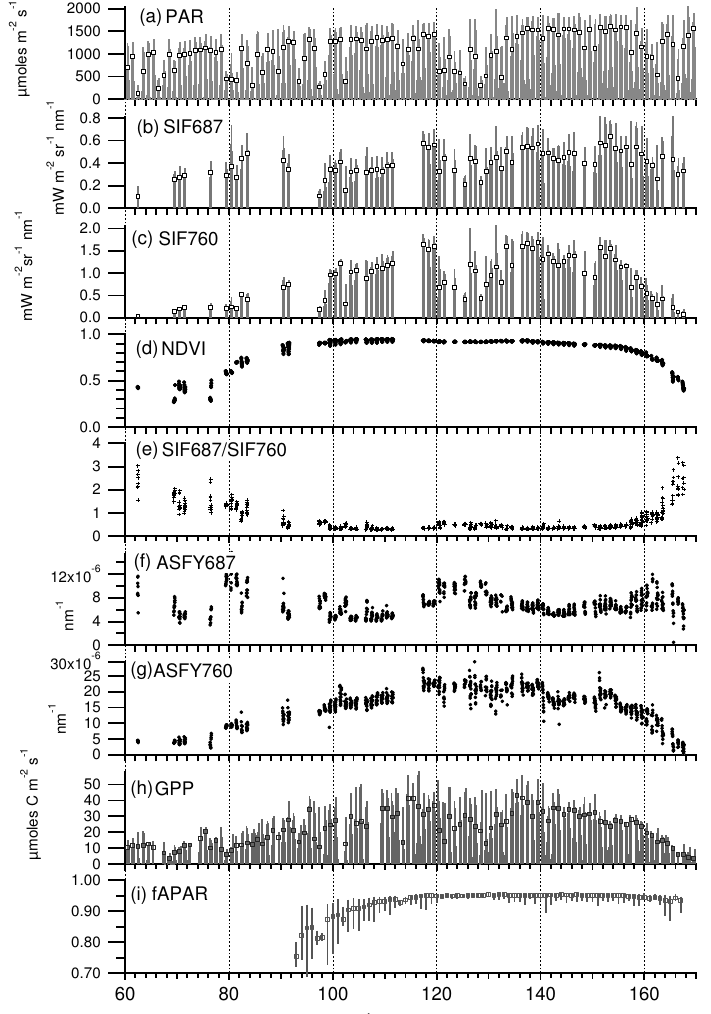
Figure 6. ( a – i ) Seasonal time course of main canopy variables (PAR, SIF687, SIF760, Normalized Difference Vegetation Index (NDVI), SIF687/SIF760, ASFY687, ASFY760, GPP, fAPAR) from growth phase to senescence. ( a – c , h ) Sticks indicate 30 min averaged values, squares indicate average over the day (8:00–15:30 UTC). . ( d – g ) 30 min averaged values. ( i )Squares indicate average over the day (8:00–15:30 UTC) and error bars indicate maximum and minimum fAPAR values during the course of the day,